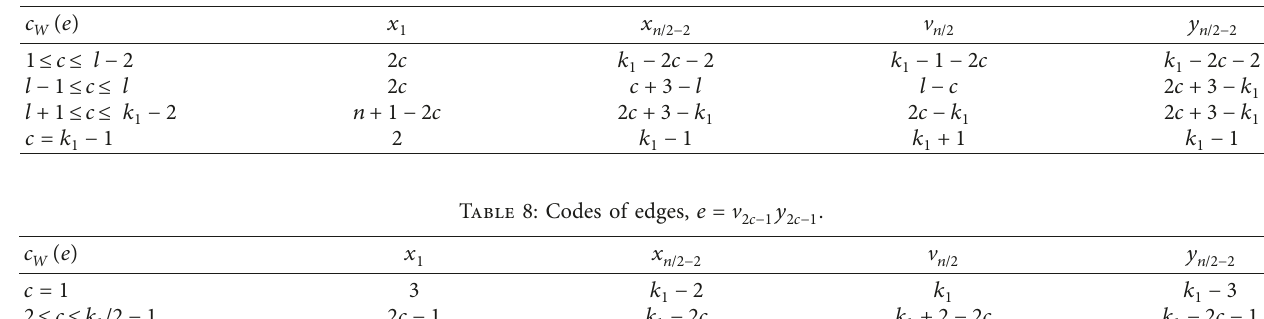
Table 7: Codes of edges, e � u